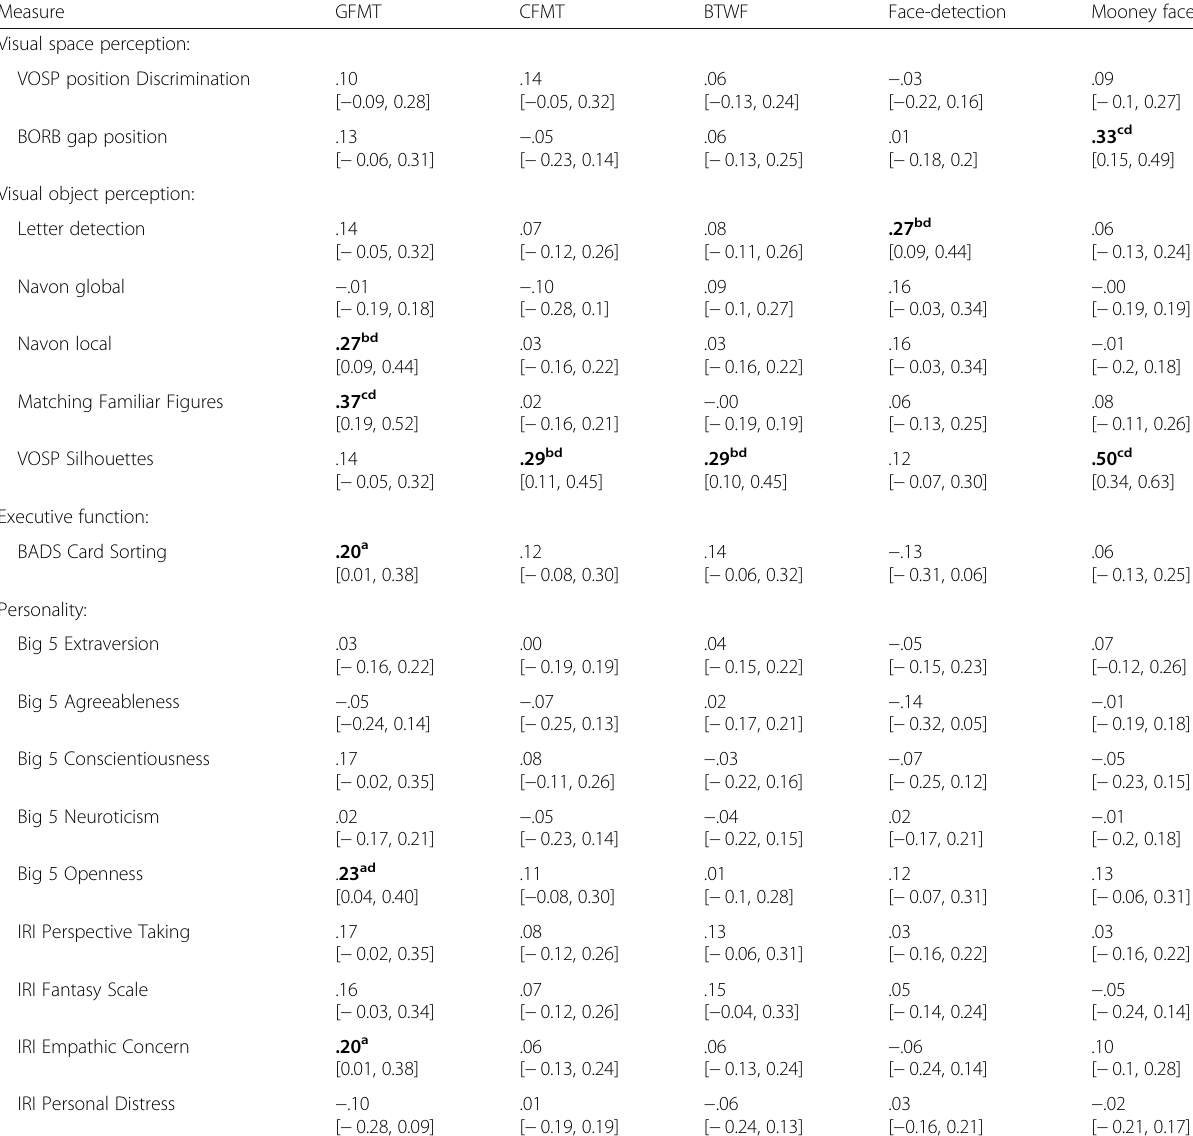
Table 4 Correlations between performance on the face-processing tasks (Face-detection and Mooney faces) and face-identity tasks (Glasgow Face Matching Test GFMT, Cambridge Face Memory Test (CFMT), Before They Were Famous task (BTWF)) and other perceptual, cognitive and personality measures in Study 2. Uncorrected significant correlations are shown in bold: a p < .05, b p < .01, c p < .001; d Significant correlations following Benjamini-Hochberg correction; 95% CI shown in